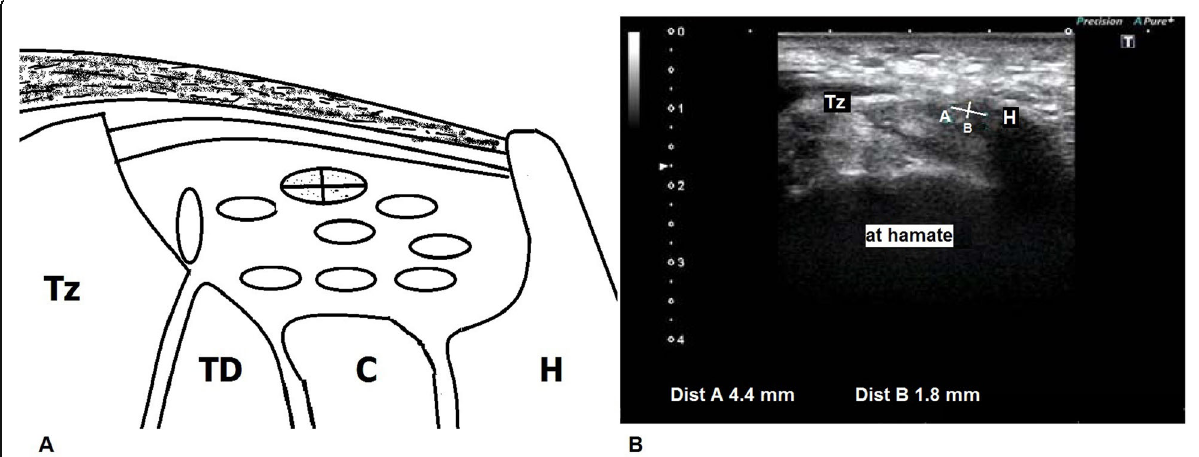
Fig. 2 a Illustration drawing for median nerve flattening ratio calculation. b Ultrasonographic median nerve flattening ratio calculation at the level of hamate (flattening ratio = Distance A/Distance B) = (4.4/1.8) = 2.4. TZ, trapezium; TD, trapezoid; C, capitate; H,